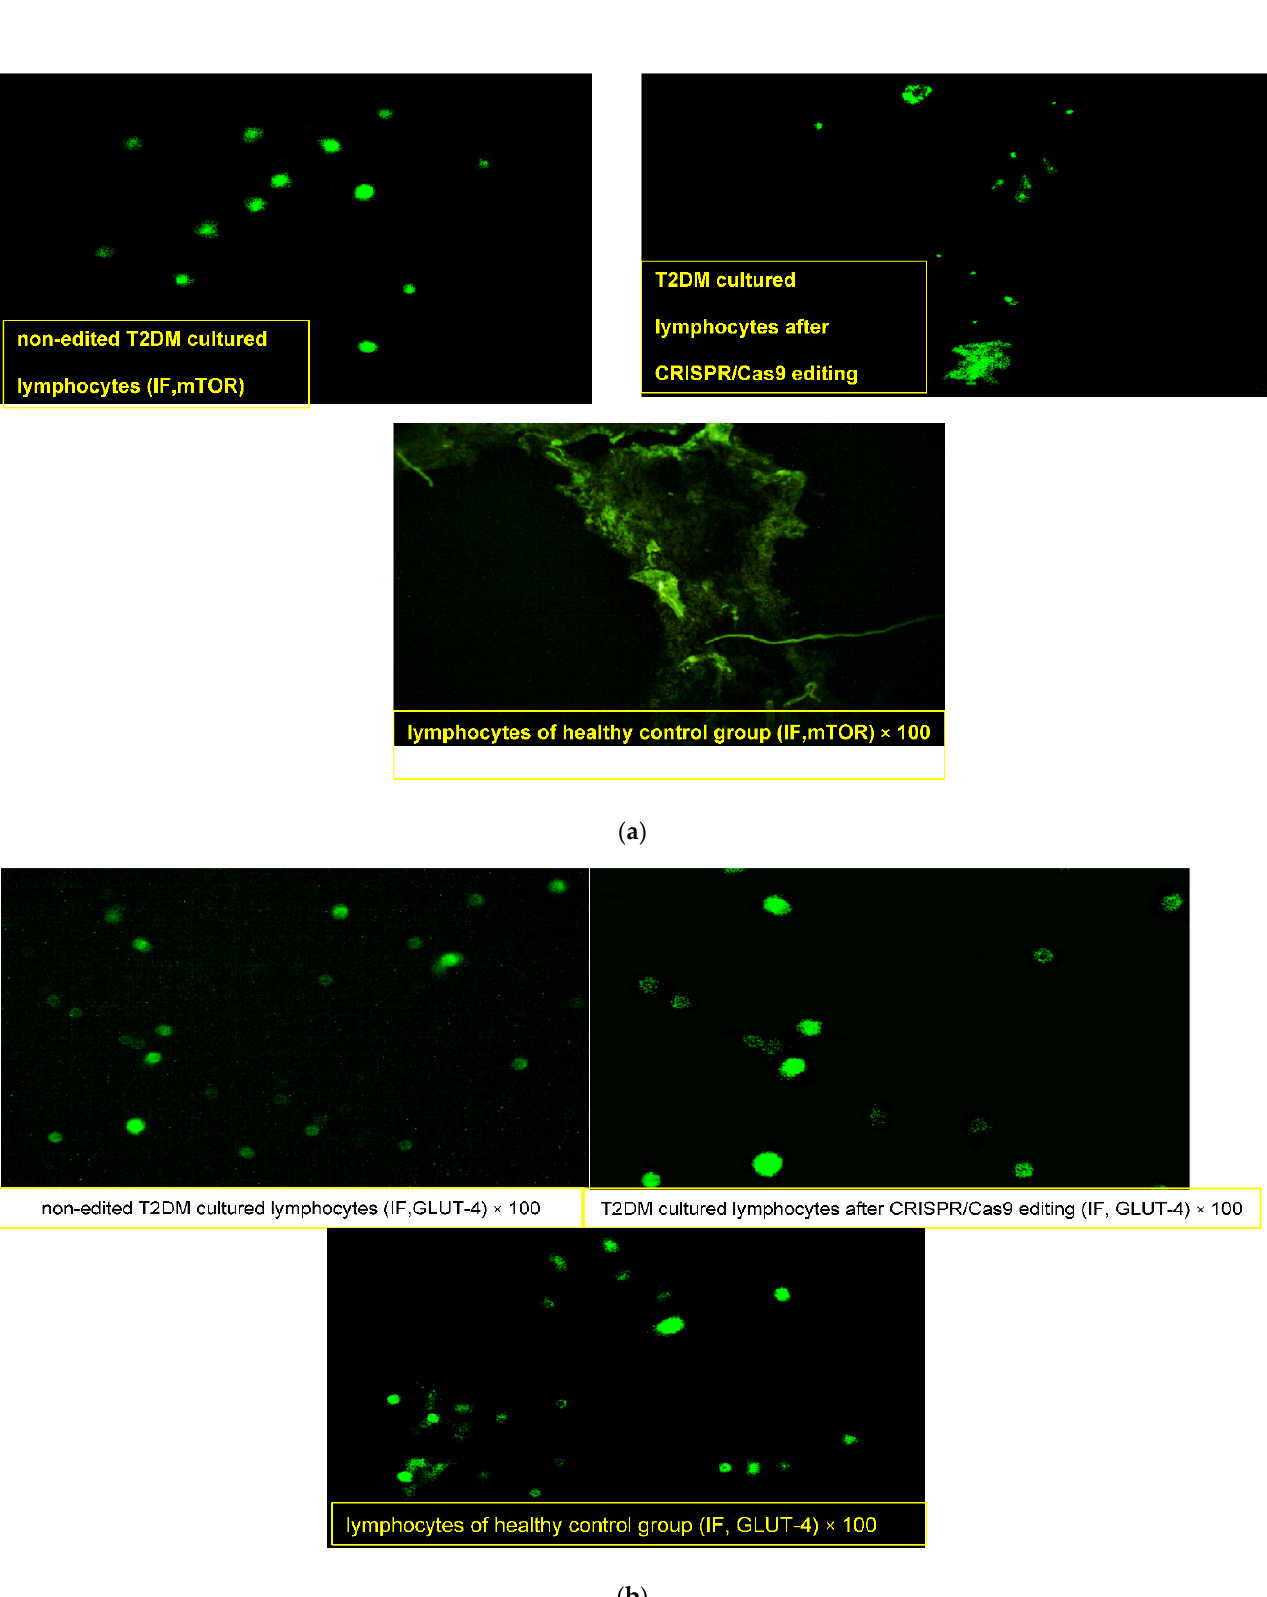
Figure 2. ( a ) Immunofluorescence assay staining of lymphocyte cultured cells with specific polyclonal antibodies against mammalian target of rapamycin (m-TOR) protein. ( b ) Immunofluorescence assay staining of lymphocyte cultured cells with specific polyclonal antibodies against solute carrier family 2 (facilitated glucose transporter), member 4 (GLUT4) protein.